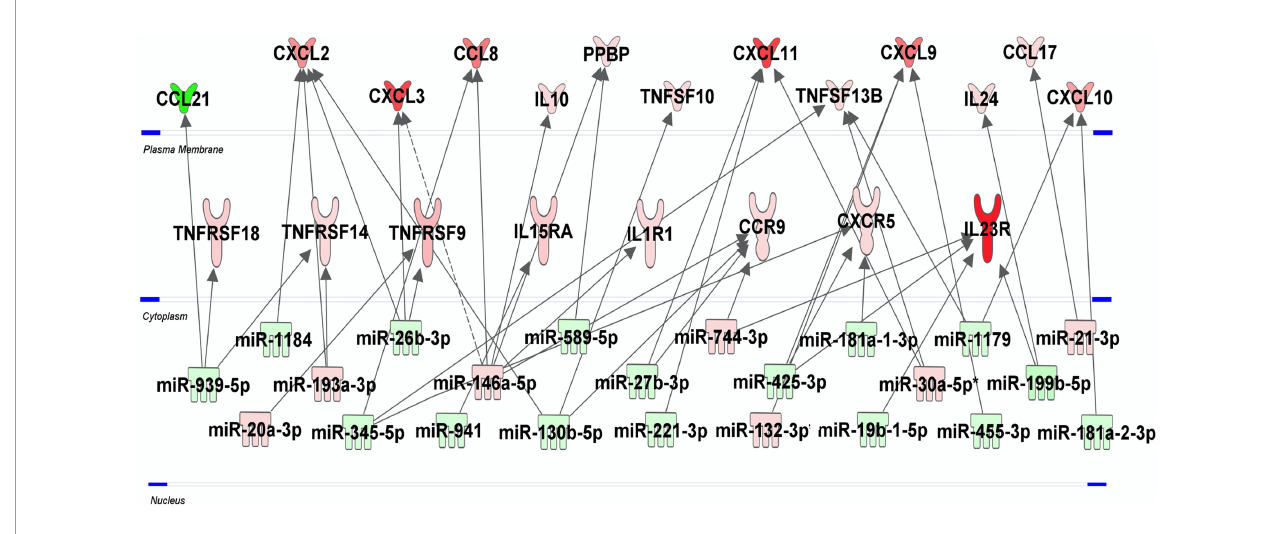
FIGURE 4 | miRNA-mRNA networks generated with Ingenuity Pathway Analysis (IPA) for H37Rv-infected human macrophages. IPA analysis was performed to investigate the connection between the 30 and 37 H37Rv-speci fi c host in fl ammatory response gene set and miRNAs, respectively. Filters were set to only include experimentally observed or high-con fi dence-predicted miRNA-mRNA interaction partners. Genes and miRNAs were colored in red or green depending on whether they were upregulated or downregulated (respectively) with respect to their uninfected controls and the shading intensity shows to what degree each miRNA or gene was deregulated. Direct and indirect miRNA-gene interactions are represented with a solid and dotted lines,